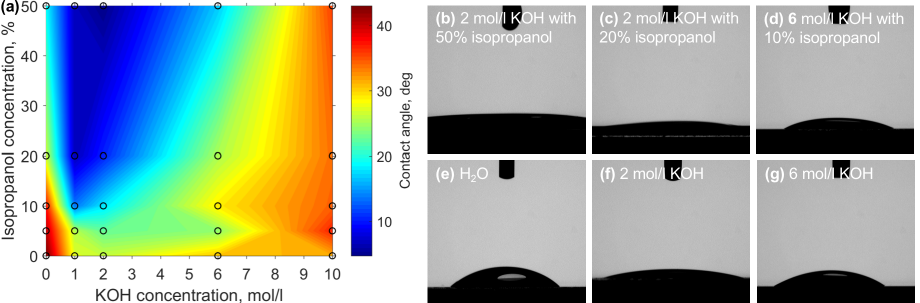
Figure 3. ( a ) Contact angle at different mixtures of KOH and isopropanol. While at the point of highest selectivity contact angle is relatively reduced, it is not the lowest measured value. ( b – g ) different etching solutions contact angle measurement